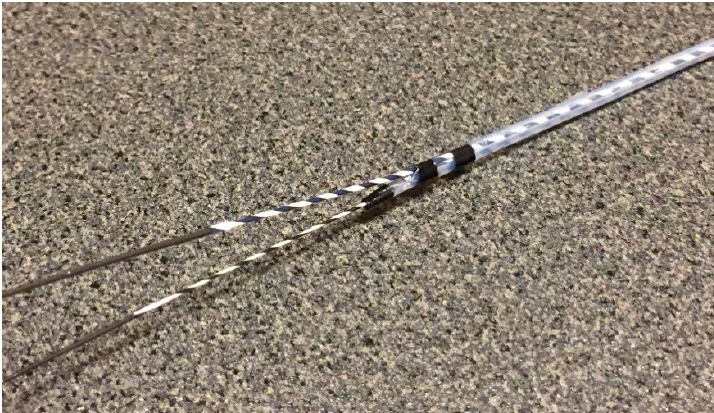
Figure 4. Uneven Double Lumen Cannula (Piolax Medical Device). The double lumen catheter allows a second 0.035 inch guidewire to be inserted adjacent to the first 0.025 inch guidewire. (Courtesy of Piolax Medical Device).